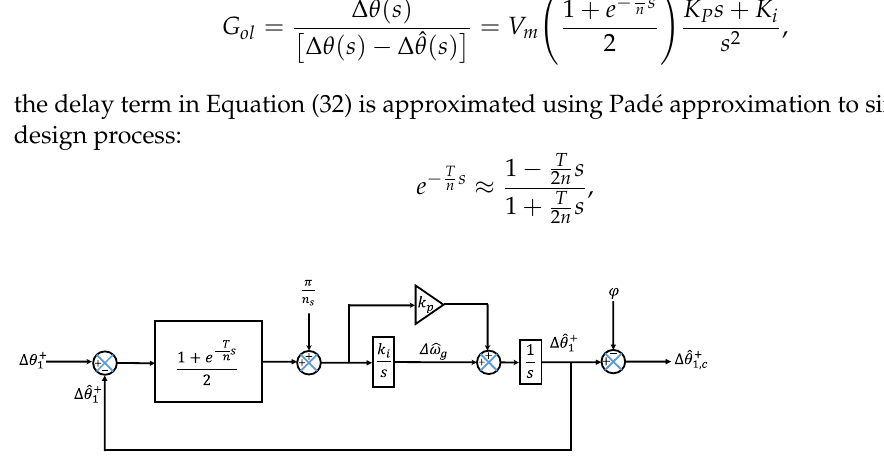
Figure 5. Mathematical model of proposed PLL.